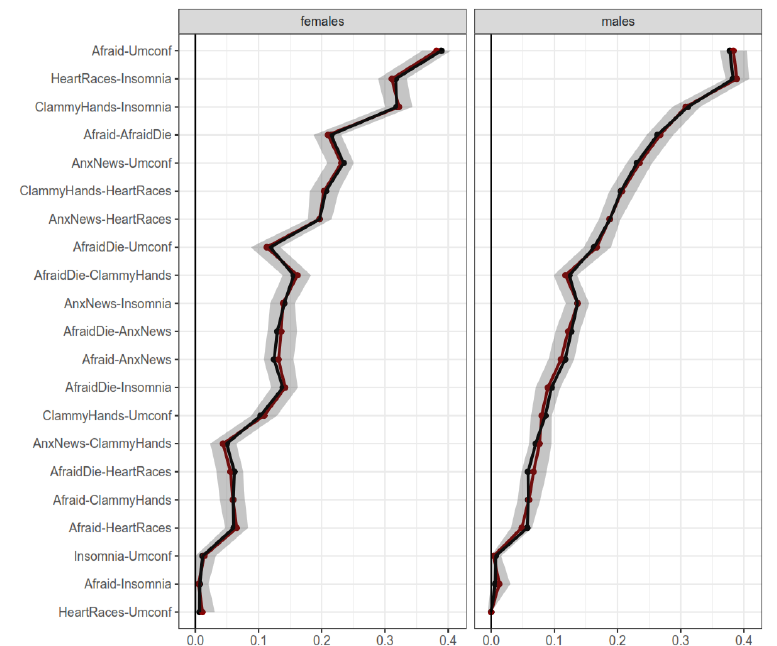
Figure 4. Bootstrapped edges for networks of males and females. Note: Horizontal axis represents edge weight. Shaded regions represent 95% confidence intervals for the measures.